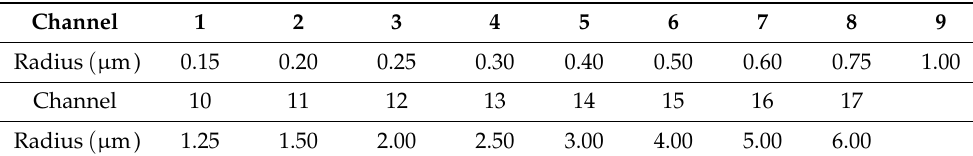
Table 1. Channel radii of OPC06 ( n = 1.59 − i0.0).